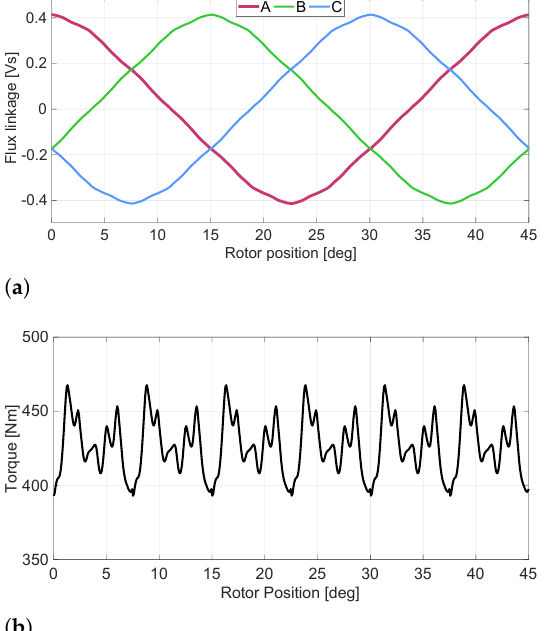
Figure 10. Analysis of the PMaREL motor. ( a ) Flux linkage, ( b ) Torque.